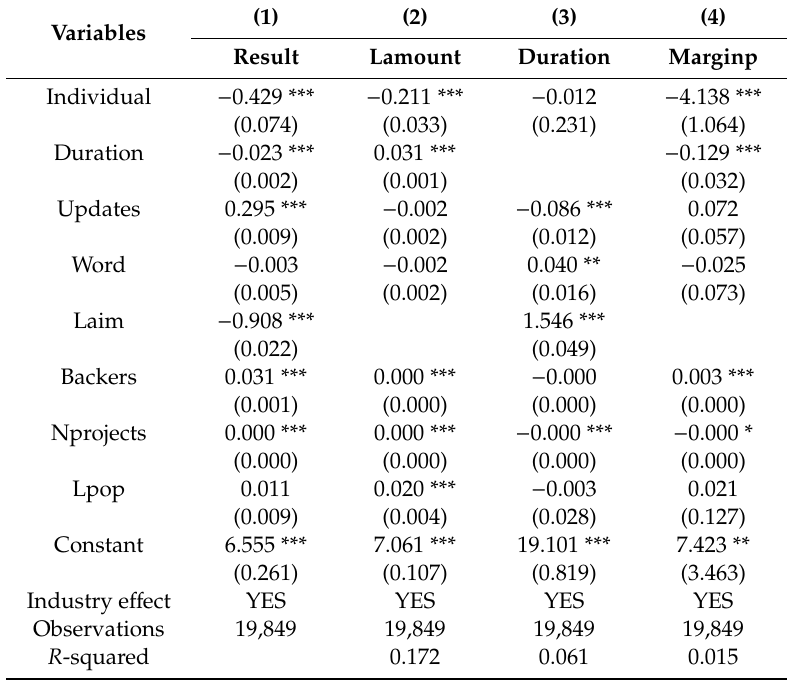
Table 8. U.S. individual results. This table reports results of regression analysis of the success, amount raised, duration, and margin (%) variables when a U.S initiator is a team. We controlled for di ff erent variables. Table 3 defines all the